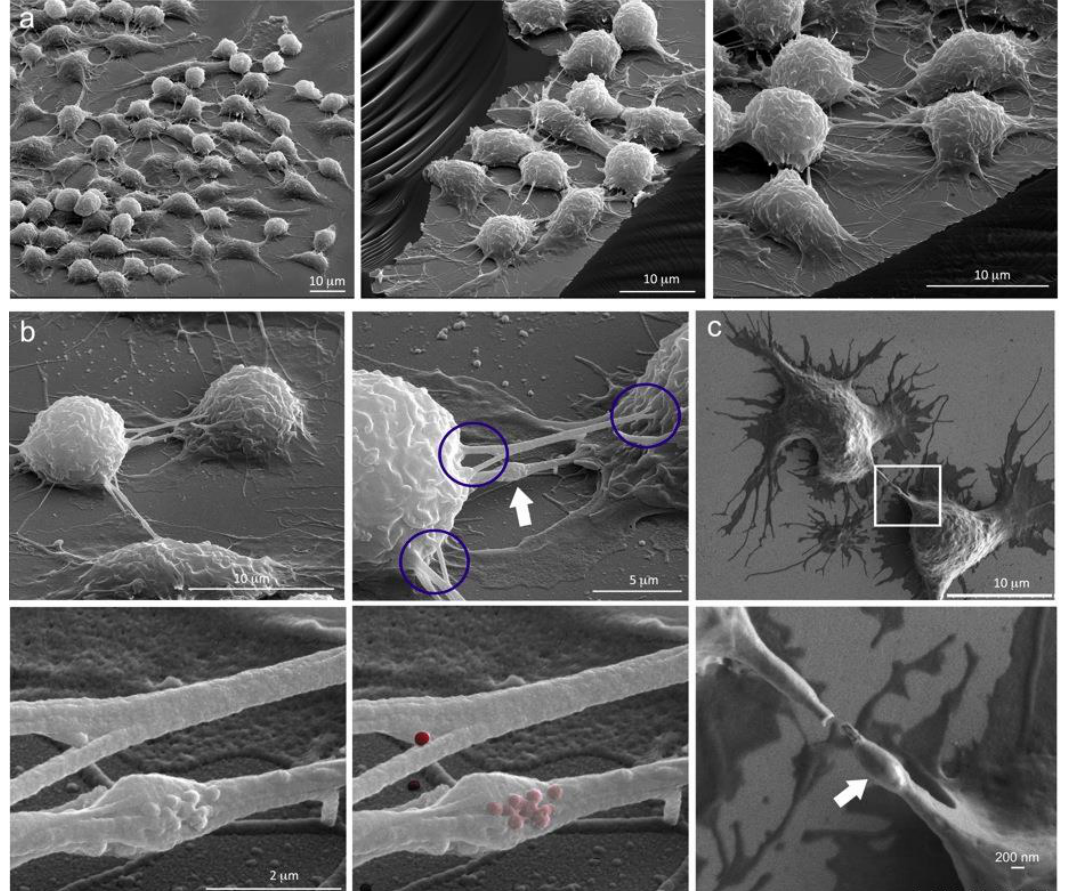
Figure 3. Macrophage TNTs and gondolas. ( a ) Three unique SEM images showing cellular connections among RAW 264.4 cells at increasing magnifications. ( b ) Series of four SEM images showing RAW